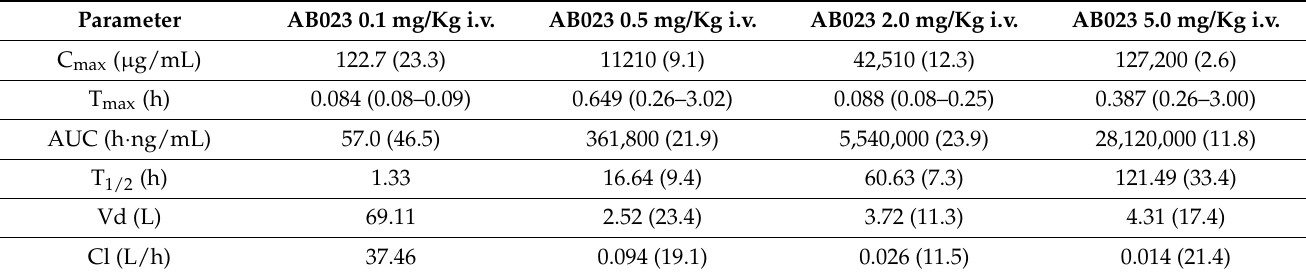
Table 6. Plasma pharmacokinetic parameters of AB023. Geometric Mean (Geometric Mean CV%) AB023 PK parameters. For T max , data are presented as median (min-max). Data are from Lorentz, C.U. et al. [27]. C max : Maximum plasma concentration; T max : time to reach C max . AUC: area under the